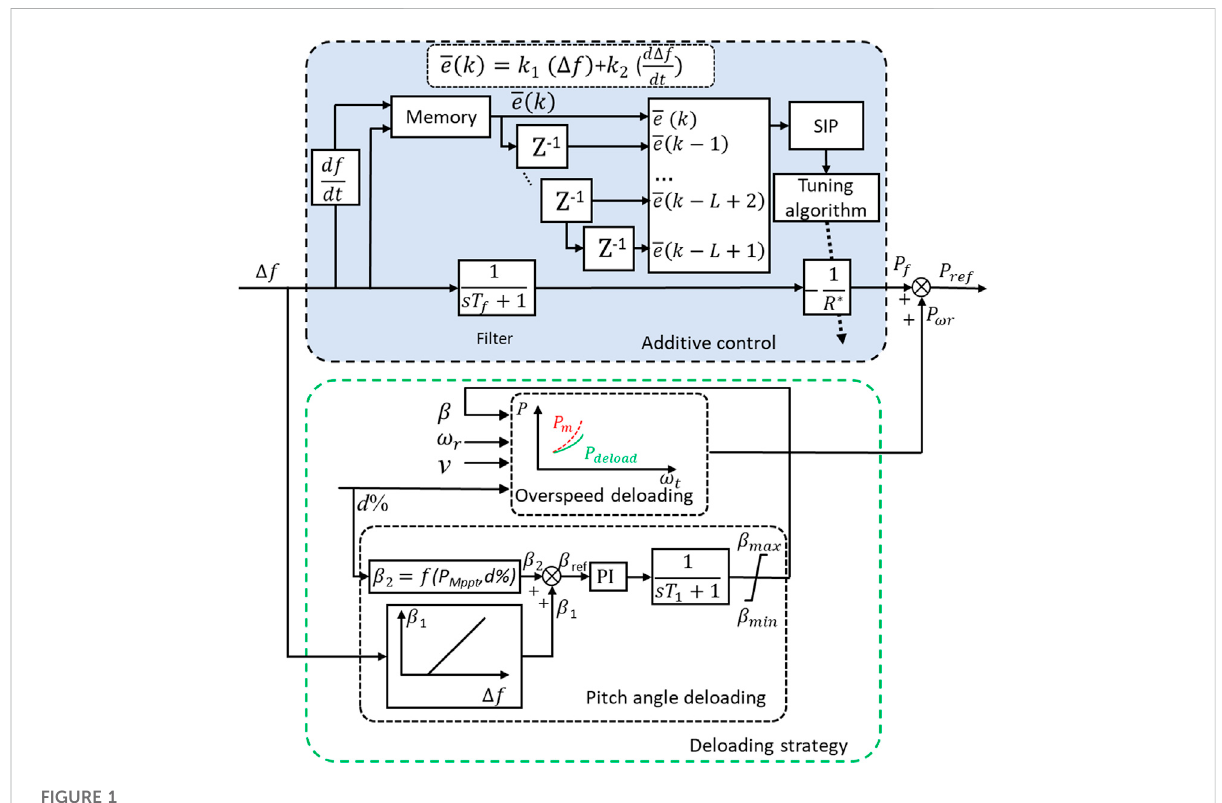
FIGURE 1 Coordinated frequency regulation